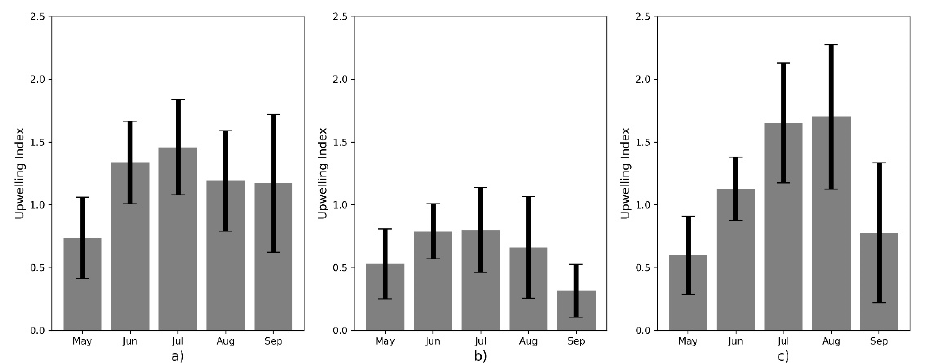
Figure 15. Monthly mean wind-driven upwelling index; ( a ) north, ( b ) central, ( c ) south. The error bars indicate 95% confidence intervals.